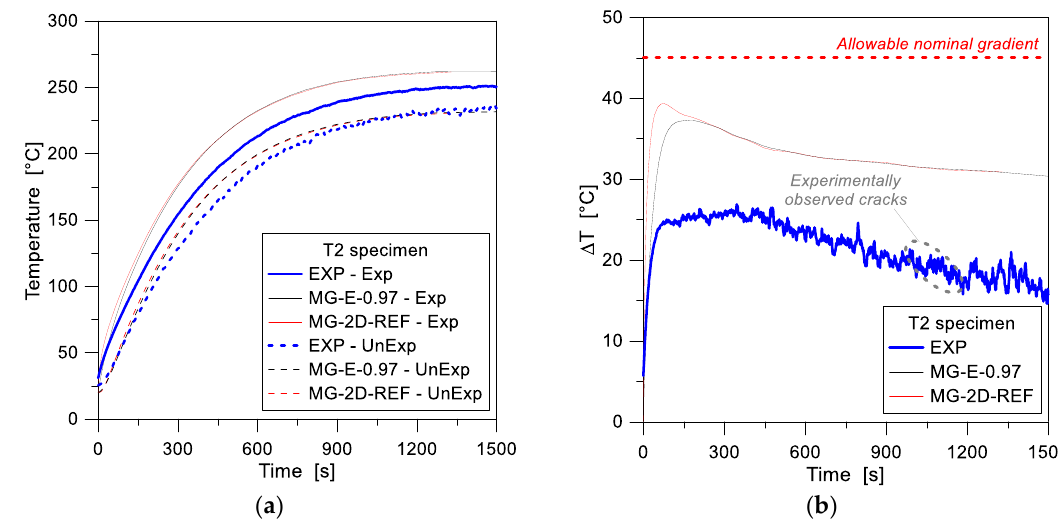
Figure 12. FE analyses (ABAQUS, 1D and 2D) and past experimental results for the MG specimen T2. ( a ) Temperature history and ( b ) temperature gradient comparisons.